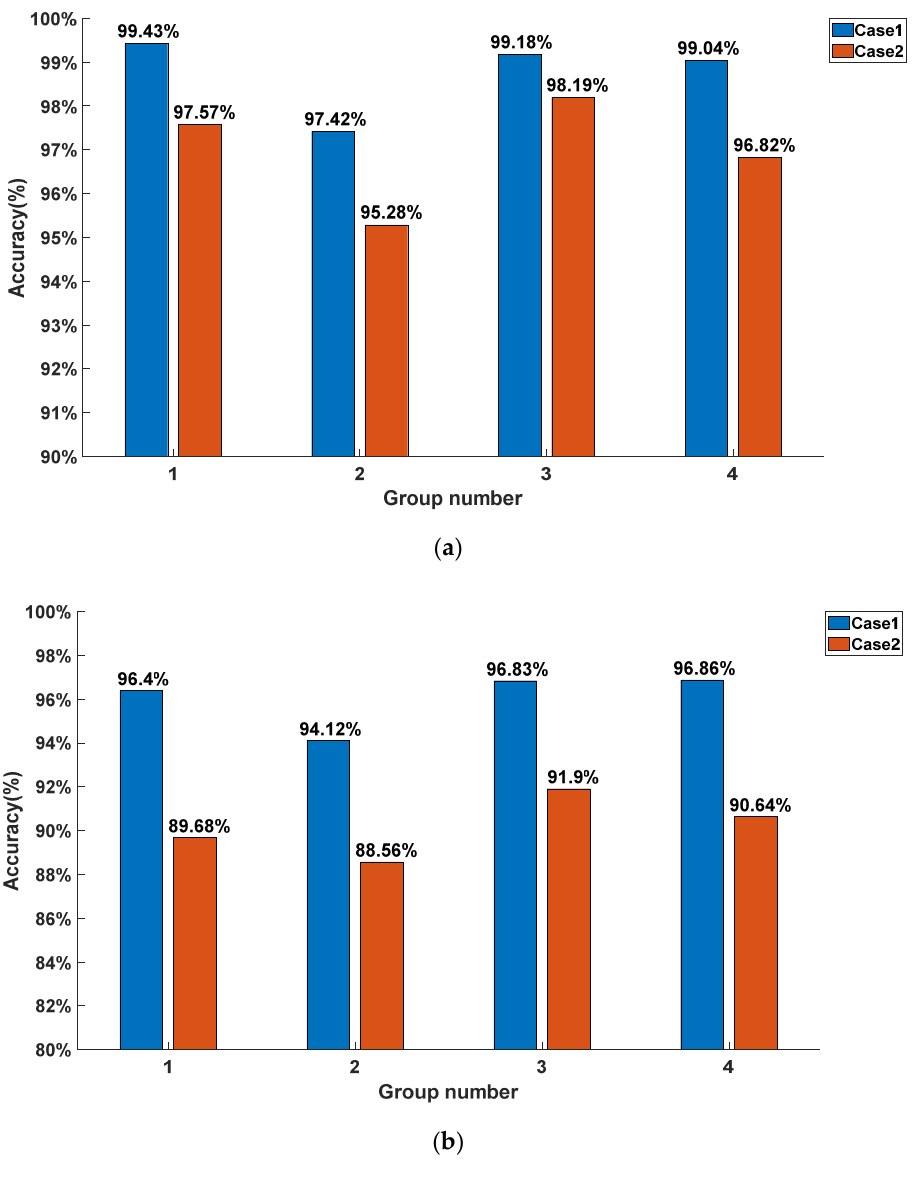
Figure 12. ( a ) The prediction accuracy of each group achieved by the DCNN–SVM model when 𝑏 = 0.3333 s ; ( b ) the prediction accuracy of each group achieved by the DCNN–SVM model when 𝑏 = 0.0667 s .